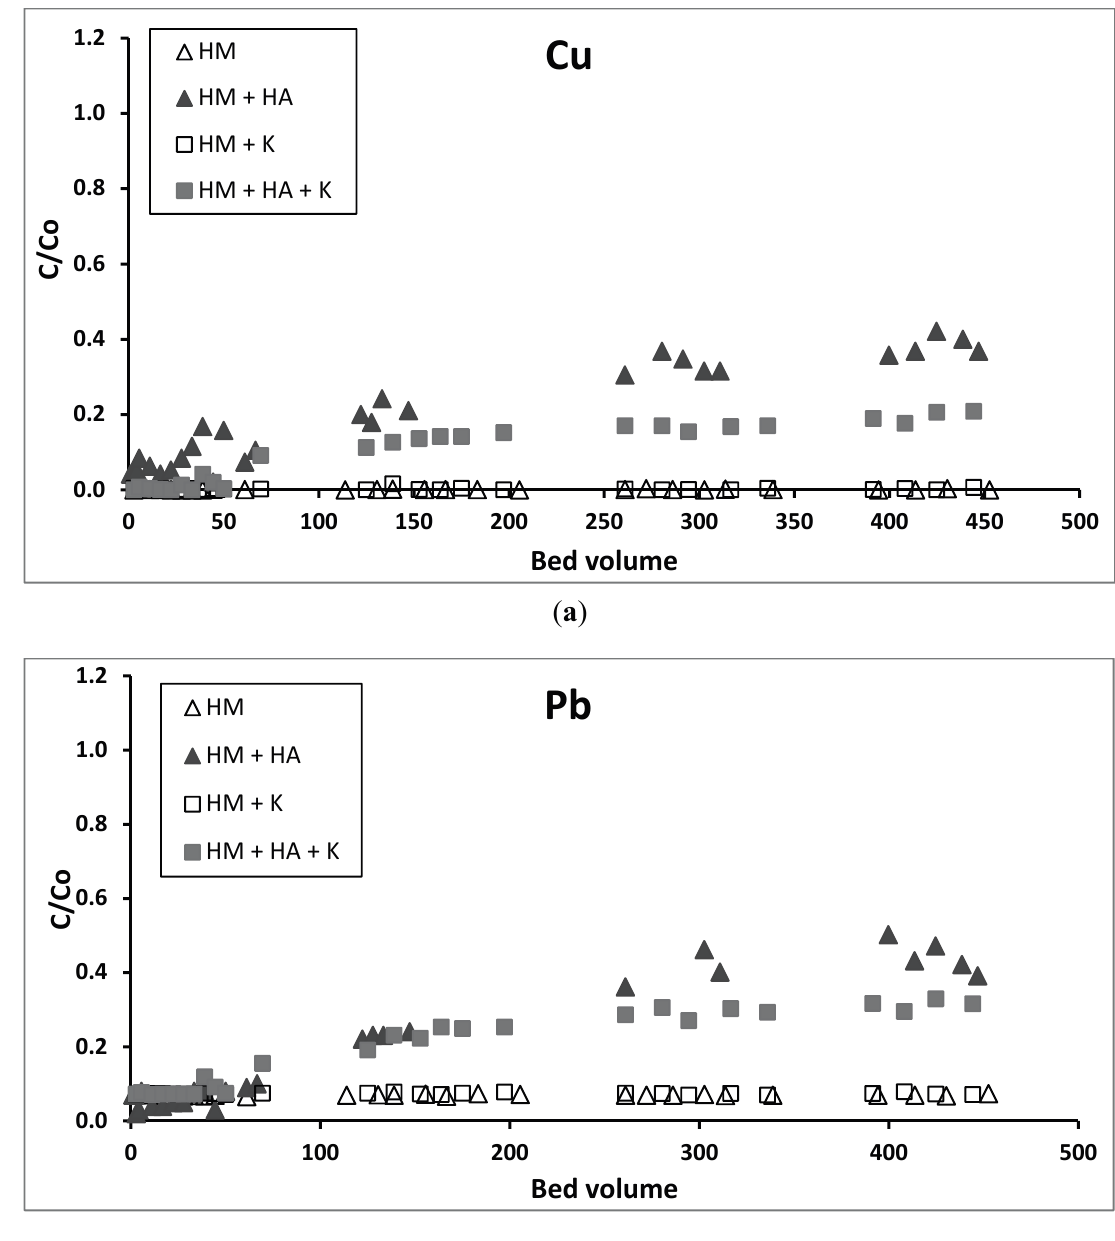
( b ) Figure 2. Breakthrough plots of ( a ) Cu and ( b ) Pb in the column